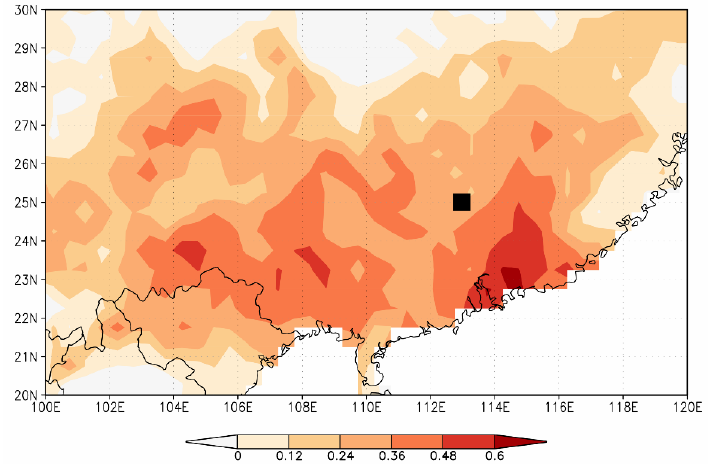
Figure 9. Spatial correlations between the reconstructed scPDSI and the CRU gridded scPDSI during 1957–2014. The black square denotes the tree ring sample site in this study.